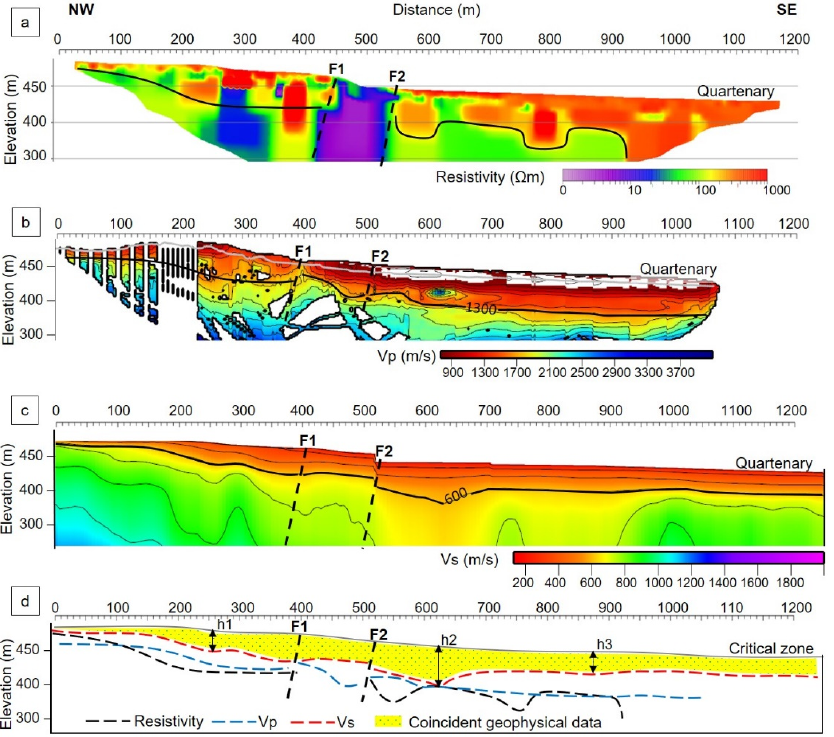
Figure 7. Geophysical imaging of the La Torrecilla with the interpretation proposed and details. Black line indicates the thickness of the CZ. ( a ) The resistivity profile, ( b ) the Vp profile from first arrival P-wave tomography, ( c ) the Vs profile from MASW, and ( d ) a joint comparison of the CZ inferred from the different geophysical methods. The dot-yellow pattern is shown when the three methods match in their interpretations. The low-velocity anomaly (limited between F1 and F2) corresponds to the AMF shear deformation zone [49]. The variation in thickness of the CZ is indicated by h1, h2, and h3.